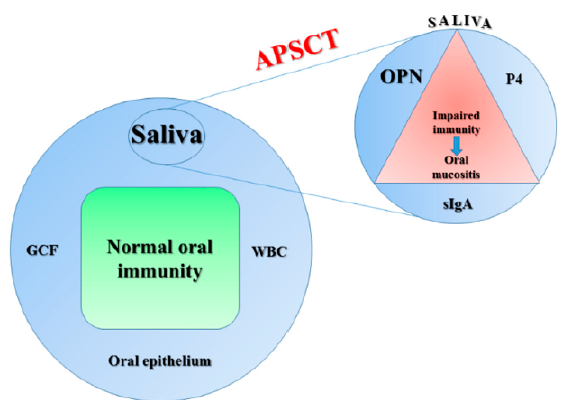
Figure 1. Pillars of oral immunity (on the left) and salivary biomarkers for oral mucositis (on the right) besides impaired immunity during autologous peripheral stem cell transplantation (APSCT) based on our previous findings. Saliva, oral epithelium, gingival crevicular fluid (GCF), and white blood cells (WBC) are key components of oral immunity, with a prominent role of saliva [1]. Changes in salivary constituents (e.g., glycoproteins-immunoglobulin A (IgA), hormones-progesterone (P4)) could be good predictors and biomarkers of several oral and systemic diseases including oral mucositis, as we reported earlier in more details